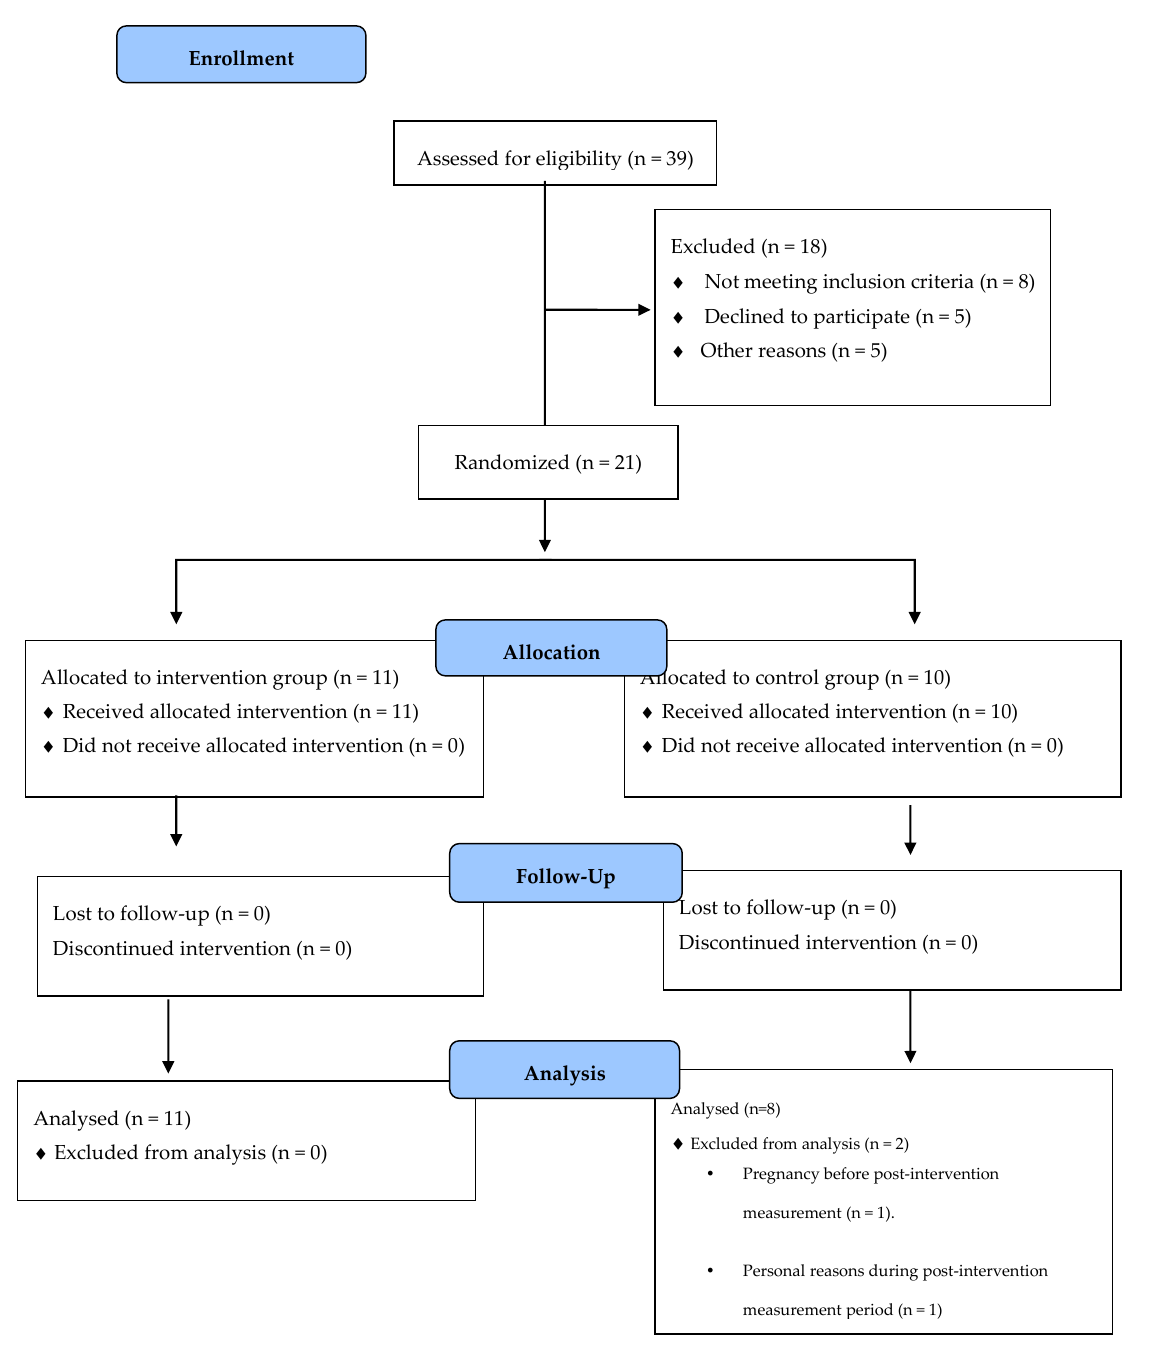
Figure 1. Flow diagram of inclusion of patients in the study.